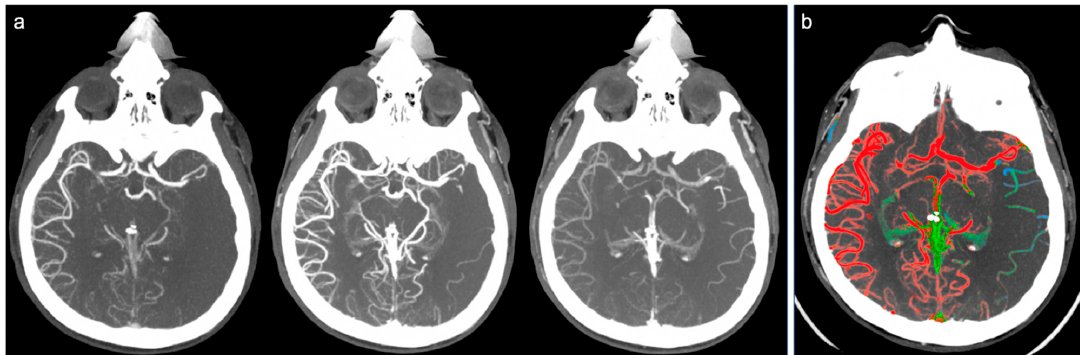
occlusion with poor pial artery filling; ( b ) ColorViz map shows reduced extension of collateral circles